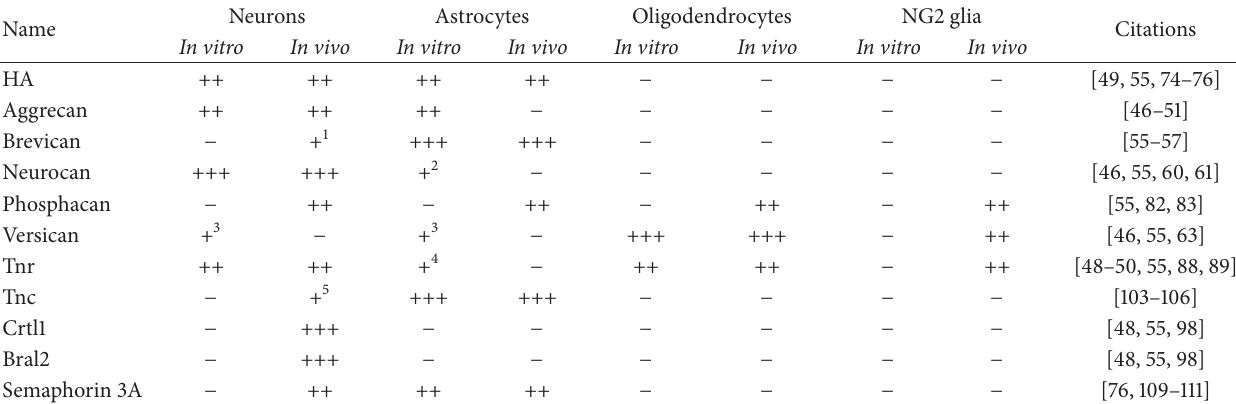
Table 1: Cellular sources of the major PNNs